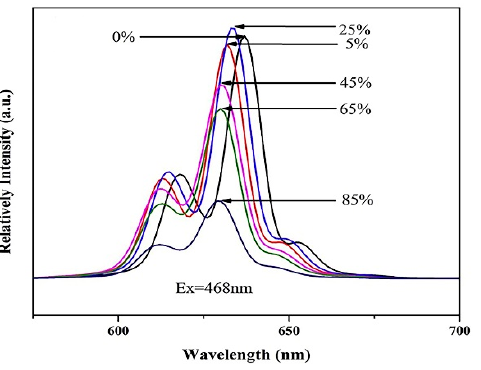
Figure 10. Emission spectra of K 2 TiF 6 : Mn 4+ @CaF 2 . (Reprinted from Ref [41]. Copyright from Elsevier, 2019).